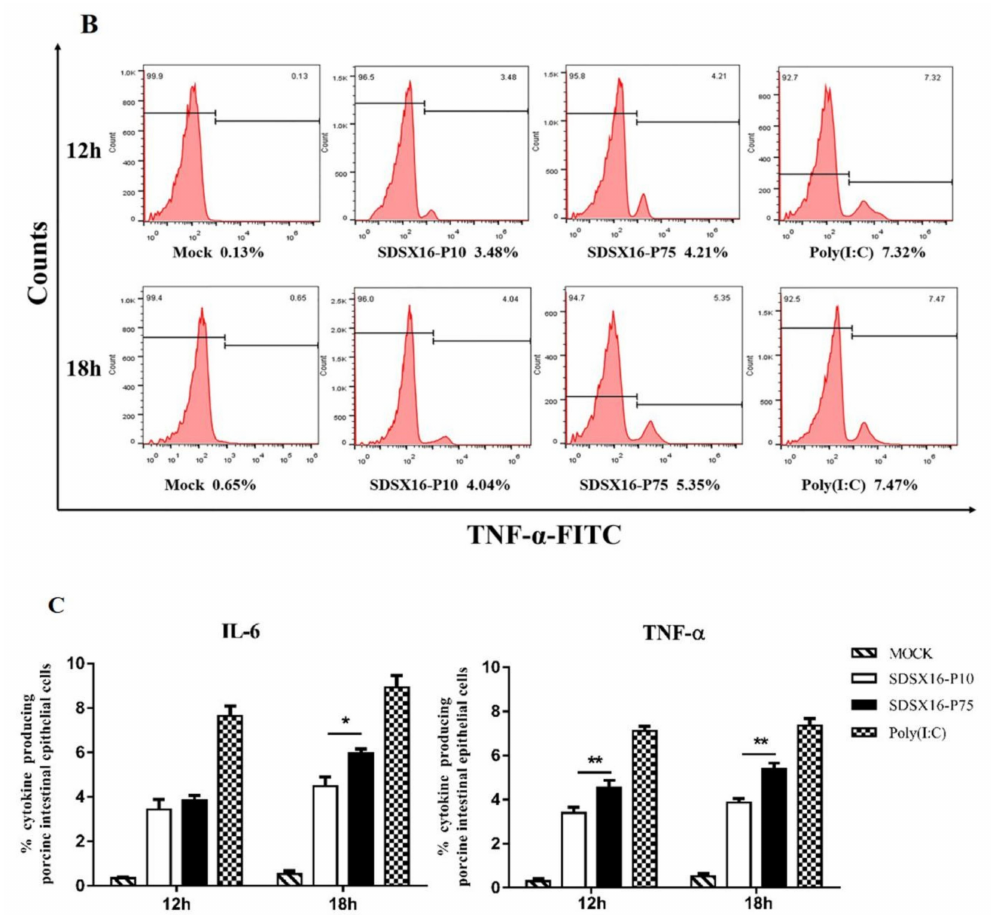
Figure 8. IL6 and TNF- α protein levels on porcine intestinal epithelial cells infected with SDSX16-P10 or -P75. The cells infected with PEDV SDSX16-P10, -P75, MMT or transfected with poly(I:C) were collected at 12 and 18 hpi. IL6 and TNF- α protein levels on porcine intestinal epithelial cells were determined individually by flow cytometry. ( A , B ) One representative experiment was shown. ( C ) The data indicated the mean ± SEM of three independent experiments, * p < 0.05; ** p <